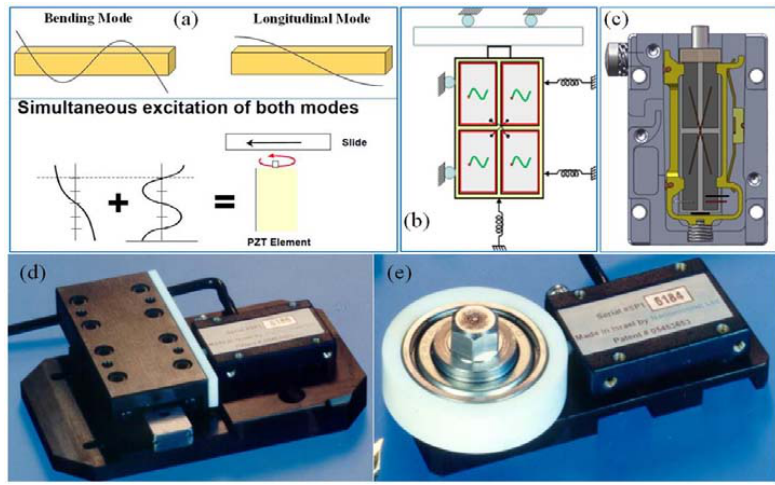
Figure 2. Basic design of an L1B2 piezoelectric ultrasonic motor: ( a ) Schematic representation of a simultaneous excitation of longitudinal and bending modes. ( b ) Schematic drawing of the preloading of a piezoelectric element onto a moving stage. ( c ) Example drawing of a Nanomotion HR1 type motor, based on a single L1B2 (Nanomotion HR type) piezoelectric element, implementing the element preloading scheme that is schematically shown in ( b ). ( d ) Image of a linear stage driven by a